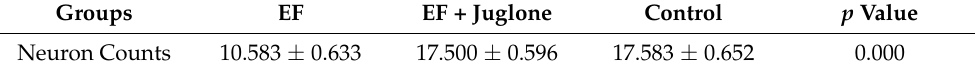
Table 3. Statistical evaluation of the neuron counts of the groups by Tukey Test method ( p = 0.001) .